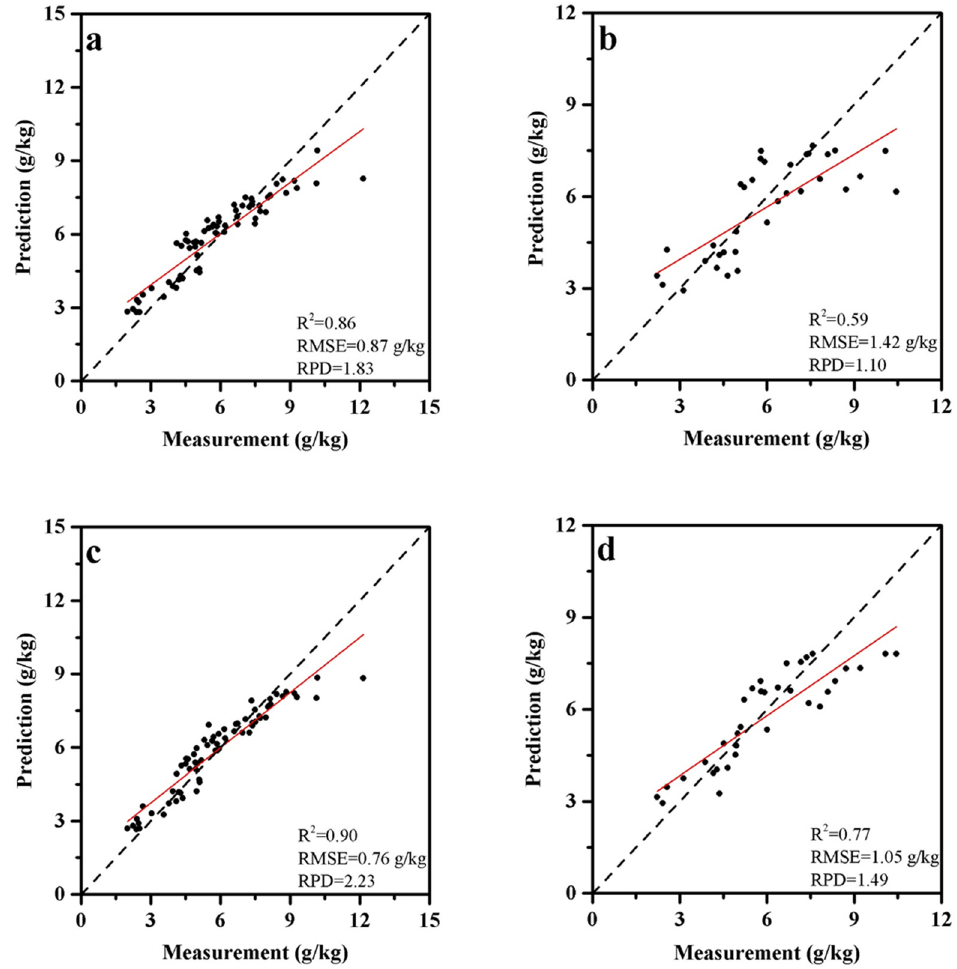
Figure 3. Relationships between measured and estimated soil carbon (SOC) values. ( a , b ) are the calibration dataset and validation dataset using the red, NIR, SWIR1 and SWIR2 bands. ( c , d ) are the calibration dataset and validation dataset using the inputs of red, NIR, SWIR1, SWIR2 and elevation, MaxC and MinC.